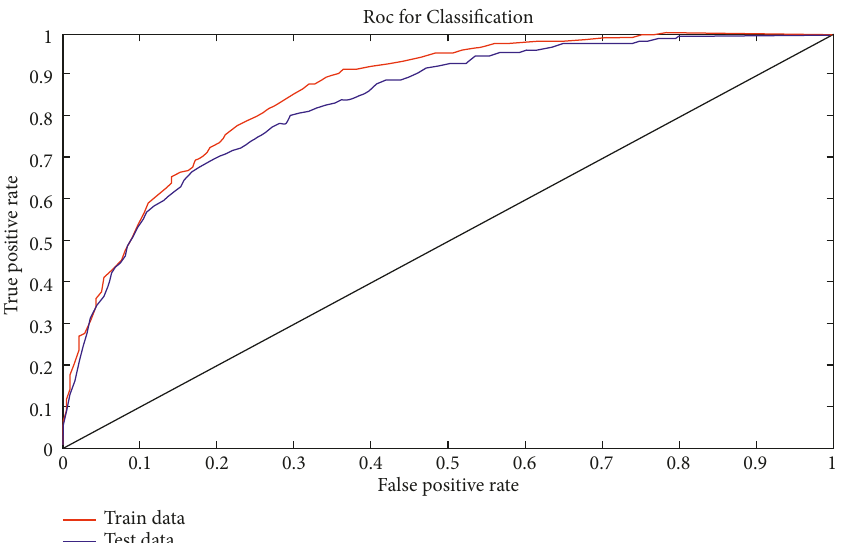
Figure 13: The area under the system performance characteristic curve diagram in the worst performance.